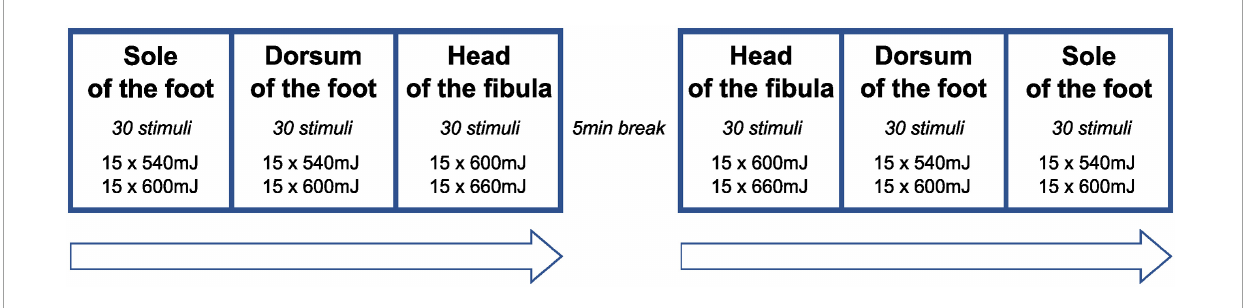
FIGURE1 Sequence of stimulation series. At each stimulation site, the two stimulation energies were applied in a random sequence (inter-stimulus interval: 7,000–9,000 ms) to avoid habituation of reflex behavior. At the head of the fibula, laser stimulation was only performed in a subset of participants ( n = 10).